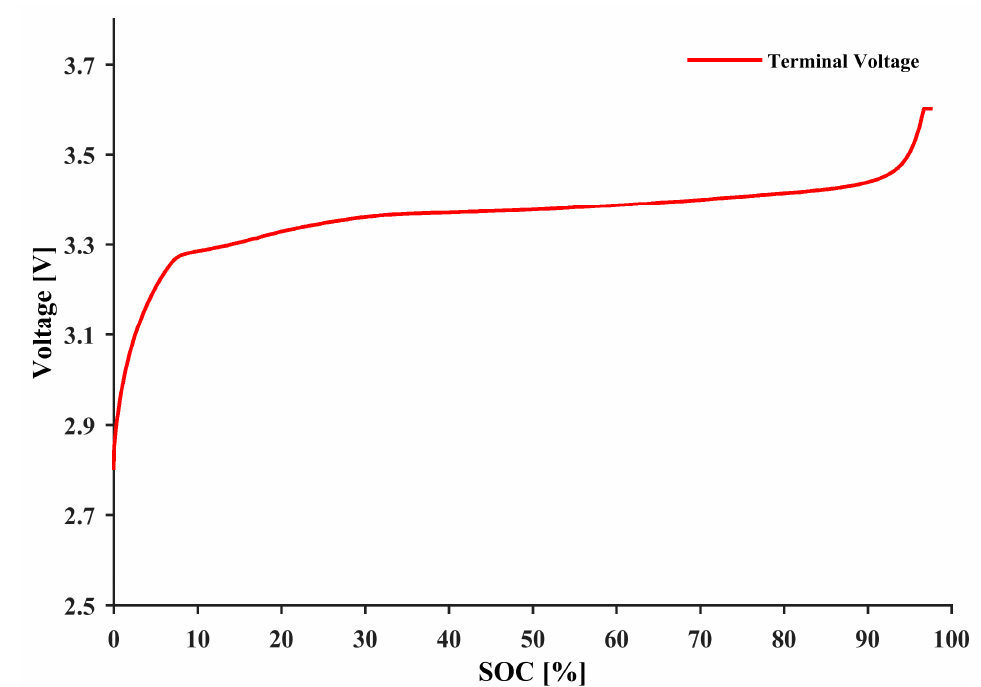
Figure 1. Relationship between terminal voltage and SOC of LiFePO 4 battery in charging process at room temperature with a 1C charging current.